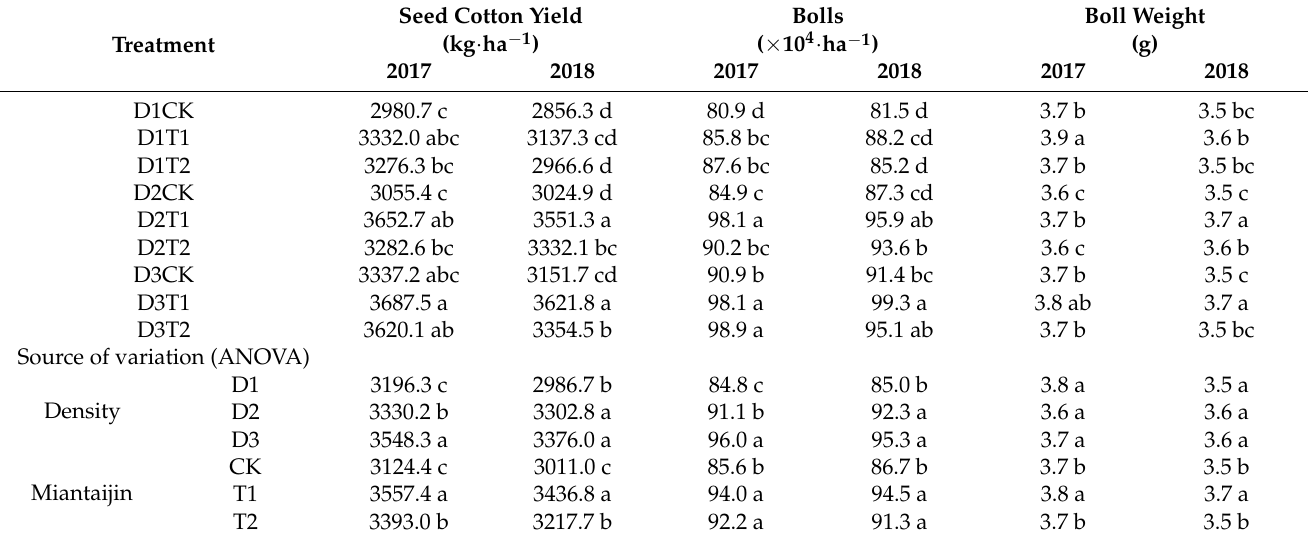
Table 2. Effects of density and Miantaijin on yield and composition of direct-seeded cotton af- ter